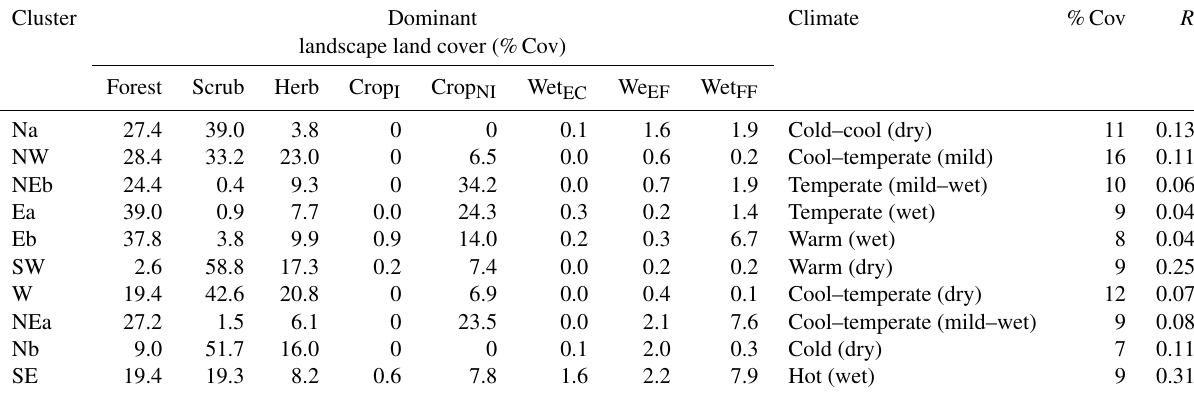
Table 2. The land cover and climate of the 10 clusters in the US. Crops were divided into irrigated (Crop I ) and non-irrigated (Crop NI ) and wetlands into emergent coastal (Wet EC ), emergent freshwater (Wet EF ), and freshwater forest (Wet FF ). Percent coverage (%Cov) is the percent area occupied by a cluster and R is the range in dissimilarity for each cluster.